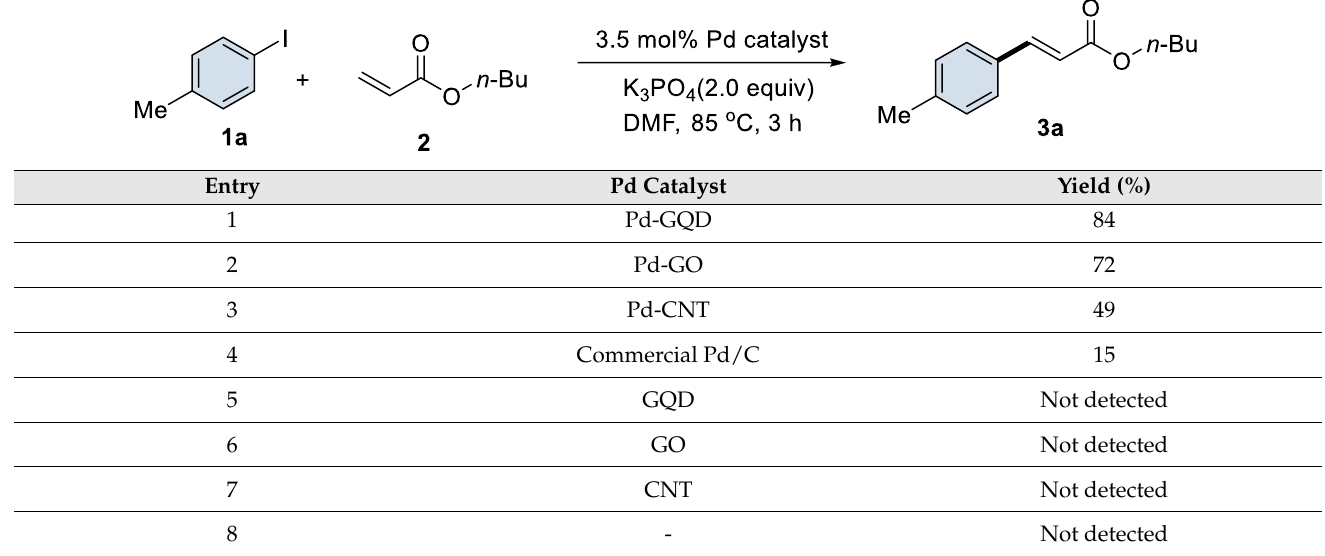
Table 1. Catalytic activities in the Pd-catalyzed Heck cross-coupling